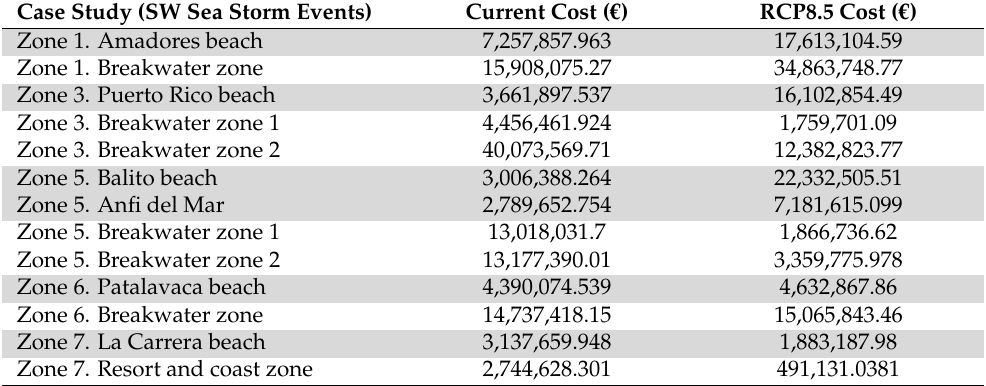
Table 5. Estimated costs in the current and future scenario (RCP